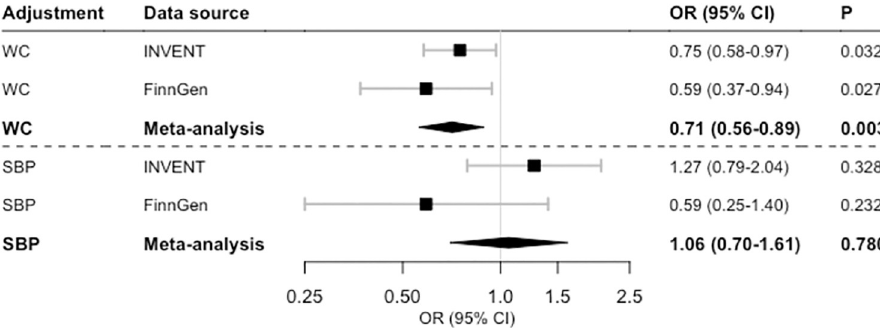
Fig 3. Association of genetically predicted one standard deviation increment of plasma cortisol levels with risk of venous thromboembolism in multivariable Mendelian randomization analysis adjusted for genetically predicted waist circumference (WC) or systolic blood pressure (SBP). Abbreviations: CI, confidence interval; INVENT, International Network Against Venous Thrombosis; OR, odds